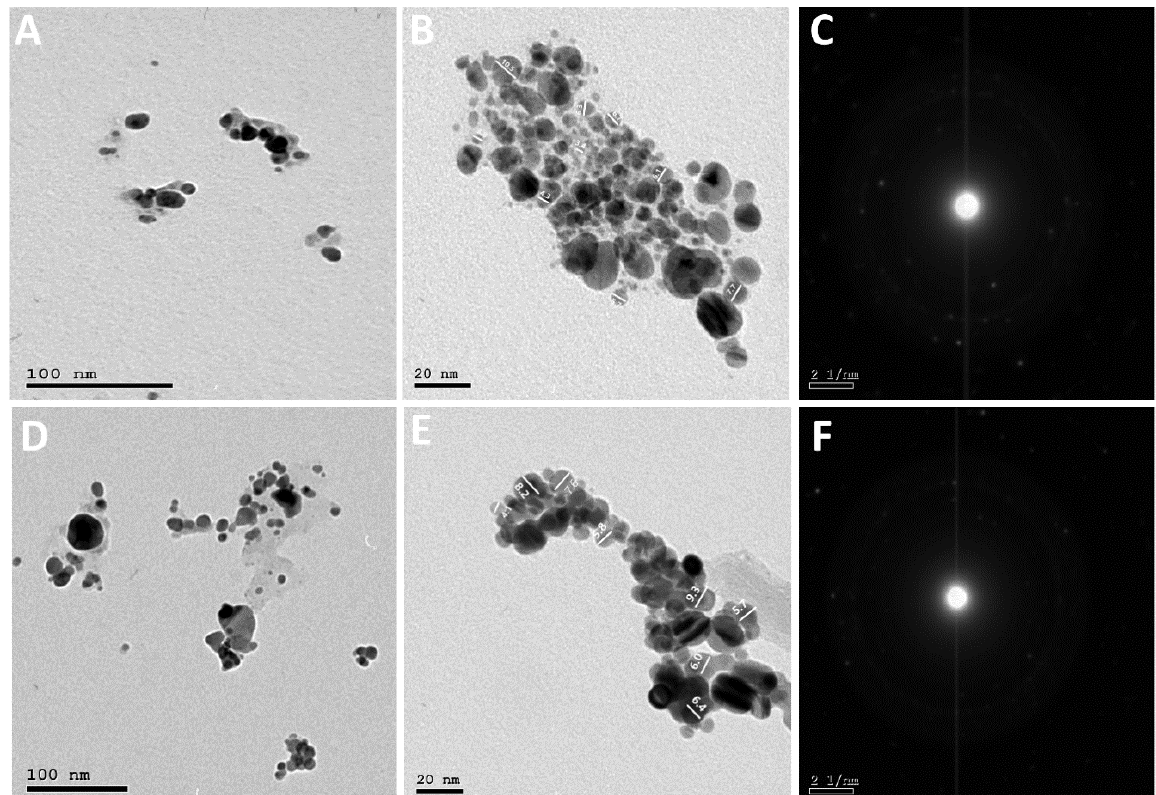
Figure 2. FTIR spectrum of the biosynthesized silver nanoparticles, ( A ): Ang-AgNPs and ( B ): Ans- AgNPs compared to their respective extracts, AngTE and AnsTE.